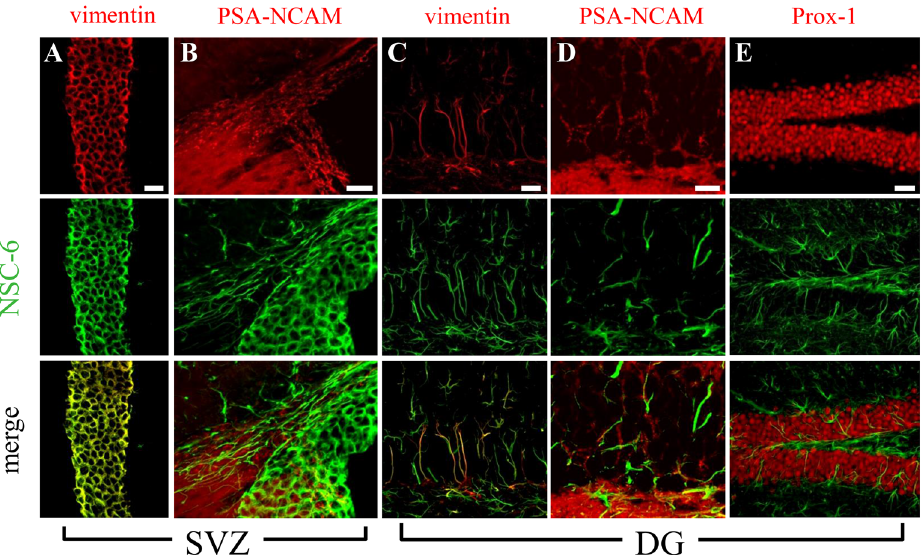
Figure 4. The NSC-6 antibody does not label neuronal lineages in the adult mouse neurogenic regions. NSC-6 immunolabeling colocalizes with vimentin ( A ) but not PSA-NCAM in the SVZ. ( B ) NSC-6 immunolabeling colocalizes with vimentin ( C ) but not PSA-NCAM ( D ) or Prox-1 ( E ) in the dentate gyrus (DG). Scale bars are 20 µm in ( A – C ); 10 µm in ( D ); and 40 µm in ( E